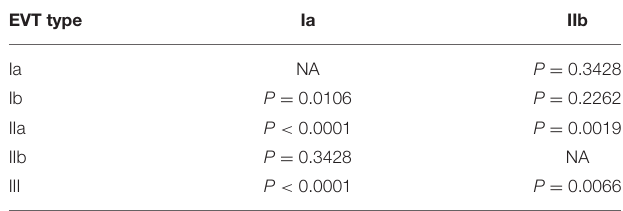
TABLE 8 | Statistical comparisons between type Ia or IIb EVTs and other